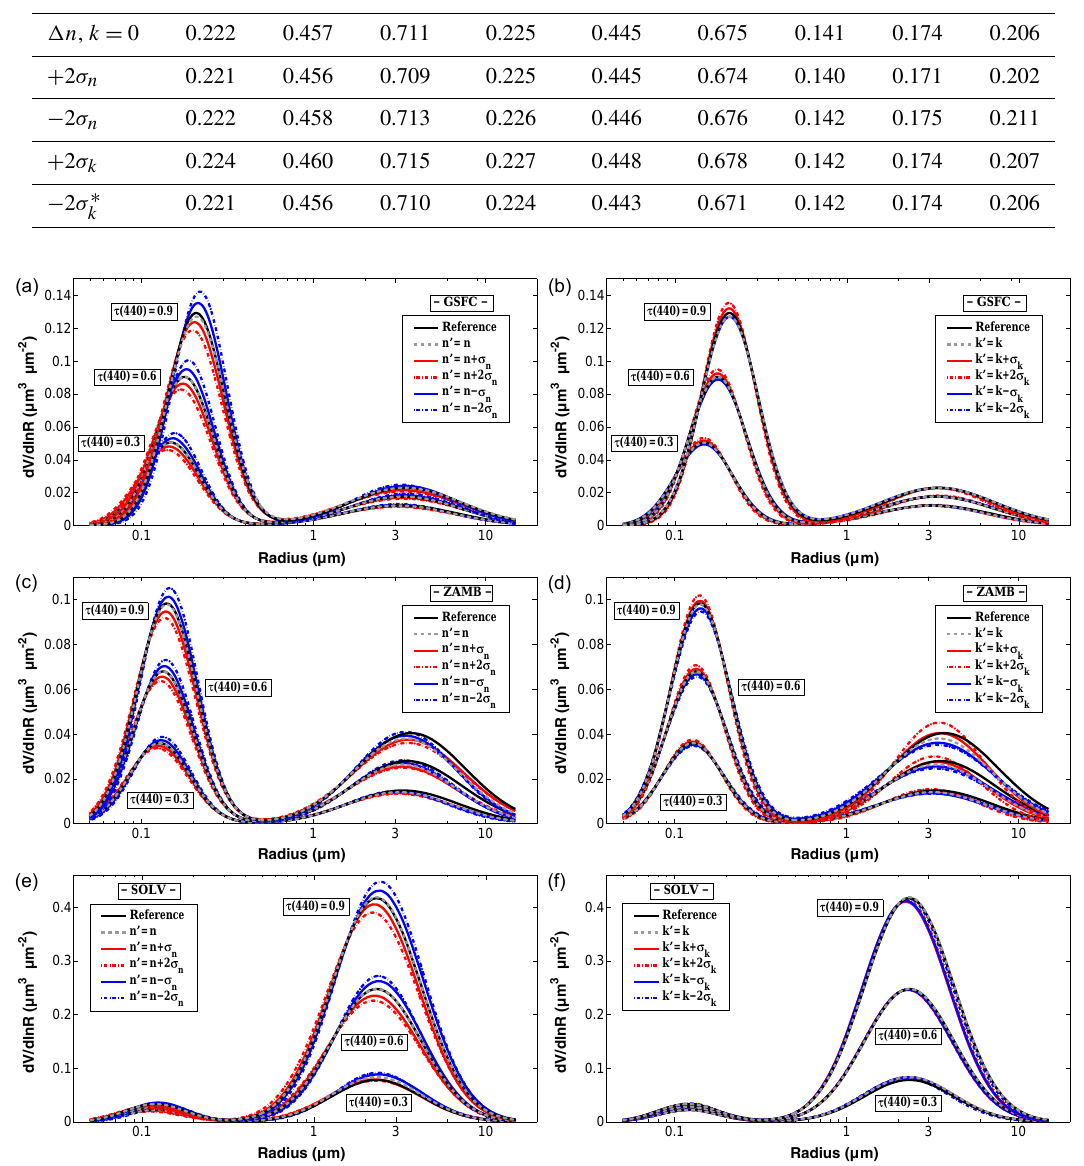
Figure 9. Sensitivity of the particle size distribution retrieval to refractive index for three of the aerosol examples: GSFC (top subfigures), ZAMB (middle subfigures) and SOLV (bottom subfigures). The subfigures on the left correspond to the sensitivity analysis, to the real part of the refractive index, and, on the right, to the imaginary part. Black solid lines are used to illustrate the reference values, while grey dashed lines represent the retrievals without variations in the refractive index (self-consistency study). Red and blue lines are used to indicate the cases for which the refractive index is overestimated and underestimated respectively. In all the subfigures, the variation of σ is represented by solid lines and the variation of 2 σ by dashed lines. The value of 2 σ n is spectrally independent and equal to 0.02 for the cases GSFC and ZAMB, while it is 0.06 for SOLV. For the imaginary part, 2 σ k has values of 0.008, 0.006 and 0.002 for ZAMB, GSFC and SOLV